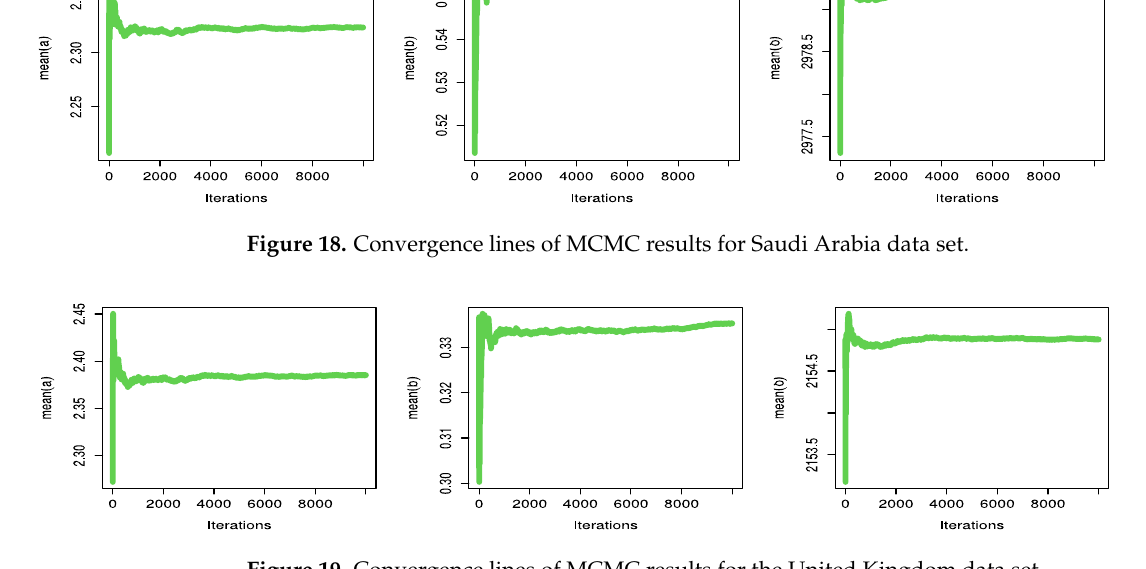
Figure 19. Convergence lines of MCMC results for the United Kingdom data set.